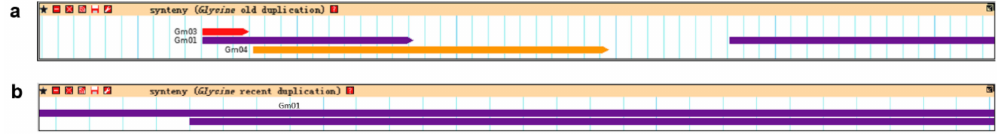
Figure 4. The duplicated regions of dsp1 and dsp2 locus from SoyBase. ( a ) The duplicated regions of the dsp1 locus. ( b ) The duplicated regions of the dsp2